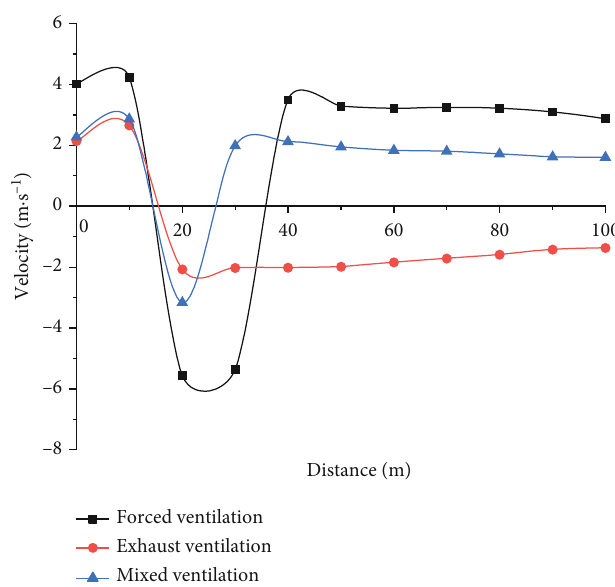
Figure 5: Curve of wind speed variation in the